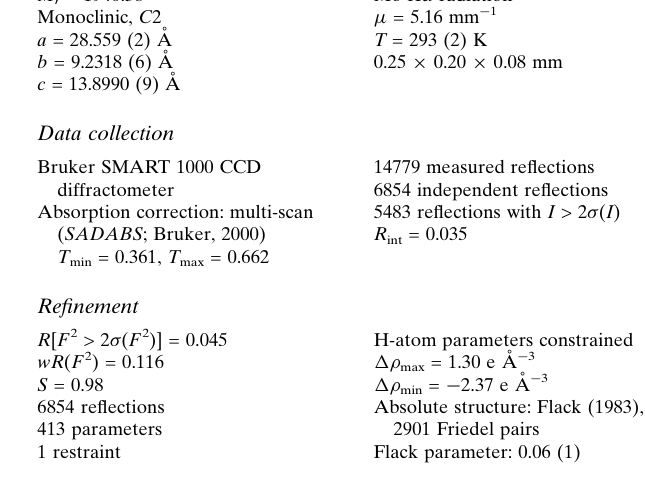
(cid:1) - H N )(H O) ]Br 15 16 4 2 2 2 (C H N )]. In the 2 15 16 4